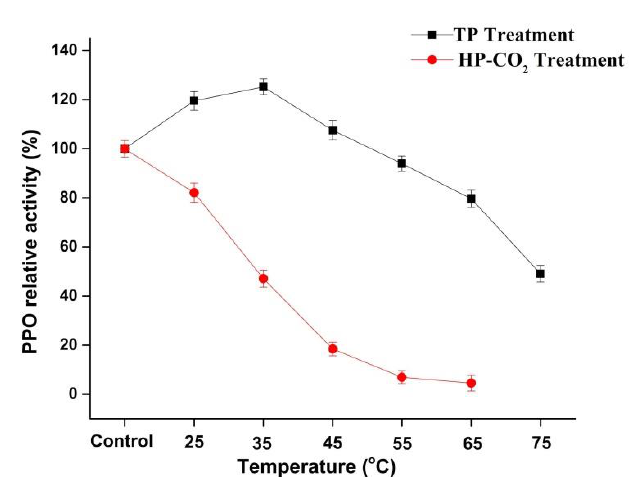
Figure 2. Relative activity of polyphenol oxidase (PPO) in apple juice under thermal processing (TP) (25–75 °C) and high pressure carbon dioxide (HP-CO 2 ) (25–65 °C for 20 MPa) treatments for 20 min. Data presented as the mean ± SD (standard deviation).